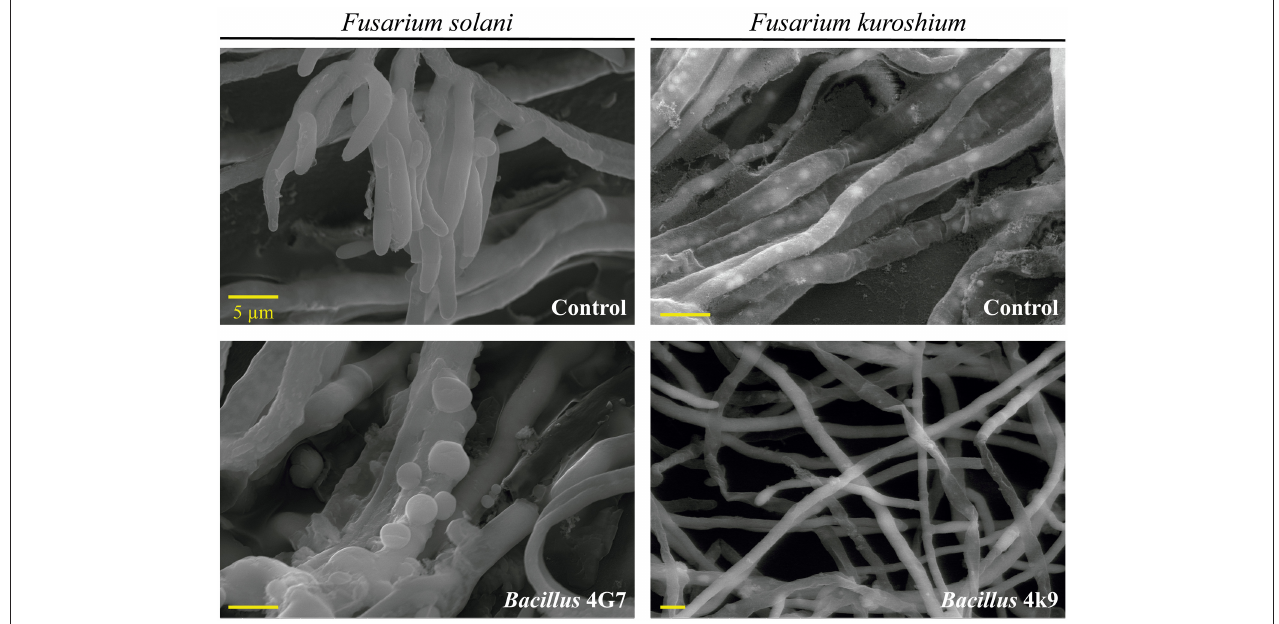
FIGURE 4 | Scanning electron microscopy (SEM) images showing the effect of VOCs emitted by Bacillus 4G7 on F. solani and Bacillus 4k9 on F. kuroshium , after 5 days of incubation.